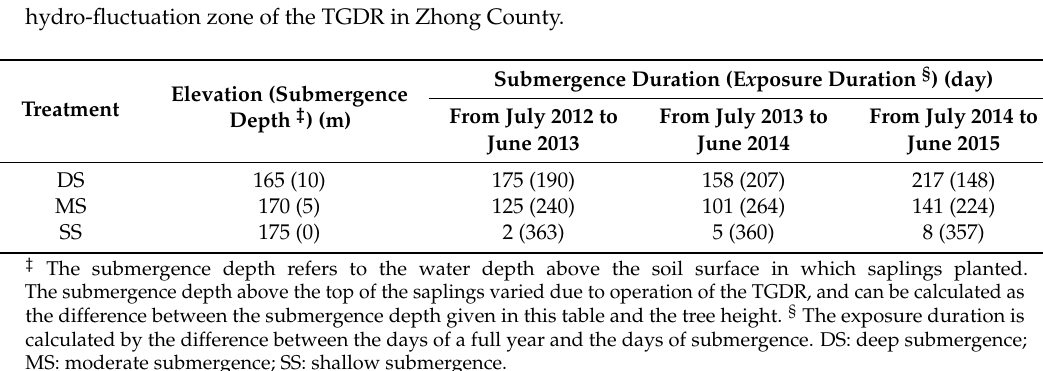
Table 1. Submergence depth and duration of each elevation during the three water cycles of the hydro-fluctuation zone of the TGDR in Zhong